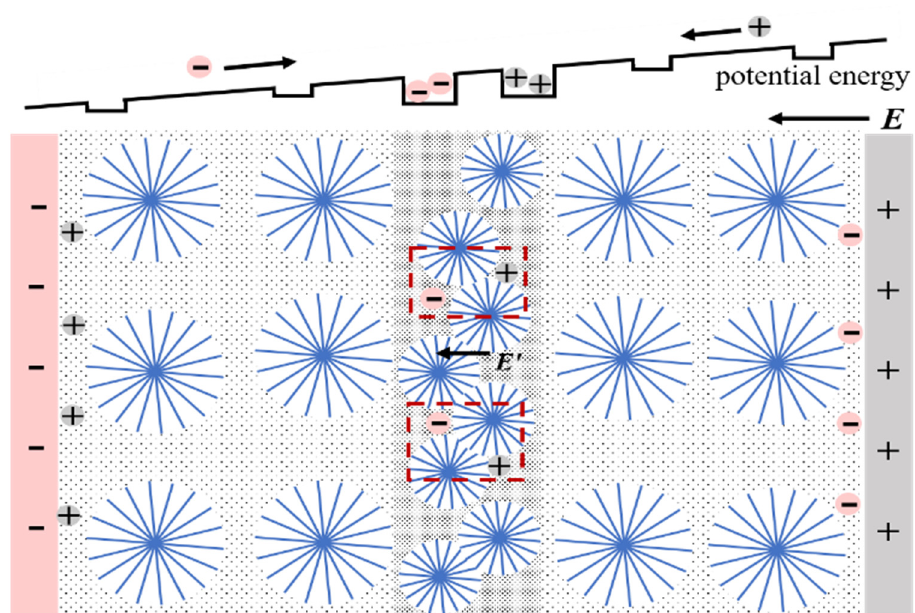
Figure 10. Schematic diagram of charge accumulation in H-XLPE bilayer.